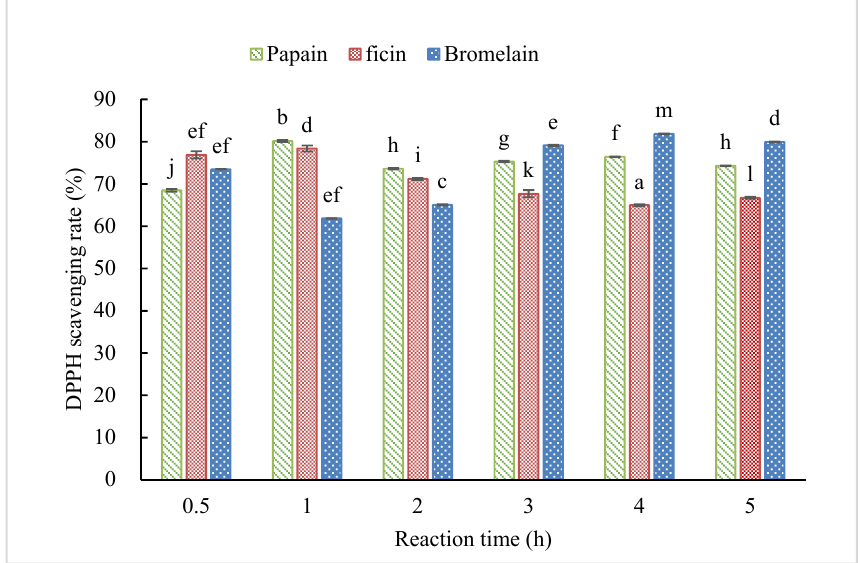
Figure 4. DPPH radical scavenging activity of hydrolysates at 5 mg/mL under different reaction times